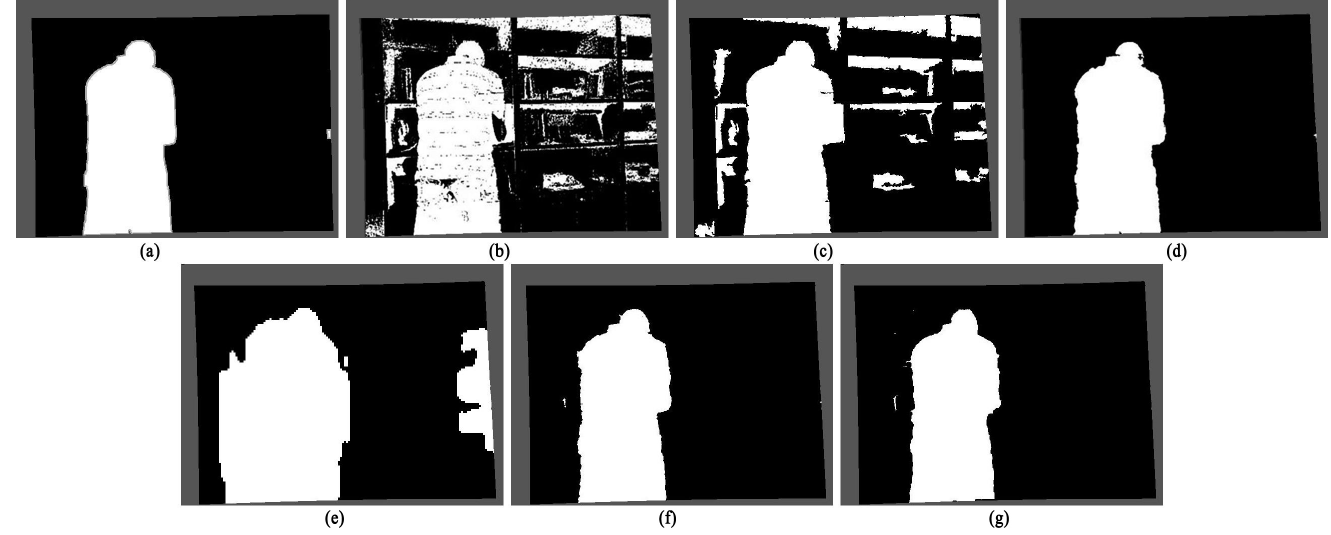
Figure 13. Comparison of the detection results of the two algorithms in Experimental Scenario Three: ( a ) Ground truth; ( b ) The detection result of the original codebook algorithm; ( c ) The detection result of the original codebook algorithm with noise points removed using morphological operations; ( d ) The detection result of the algorithm proposed in this article; ( e ) The detection result of the SRPCA method; ( f ) The detection result of the CwisarDH + method; ( g ) The detection result of the BSABU